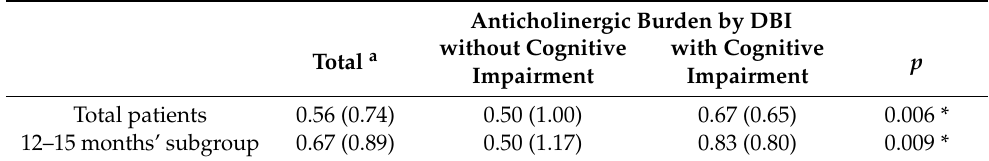
Table 3. Anticholinergic burden by DBI in total patients and in 12–15 months’ subgroup, with and without cognitive